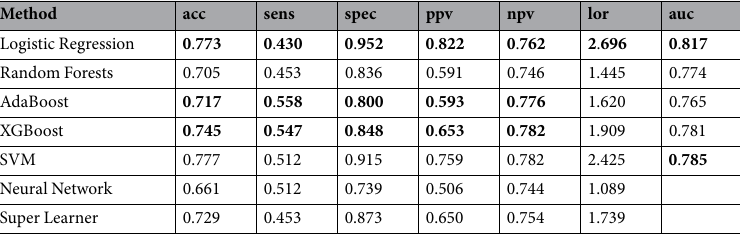
Table 21. Performance of model-based and model-free methods (using selected features) on aggregated